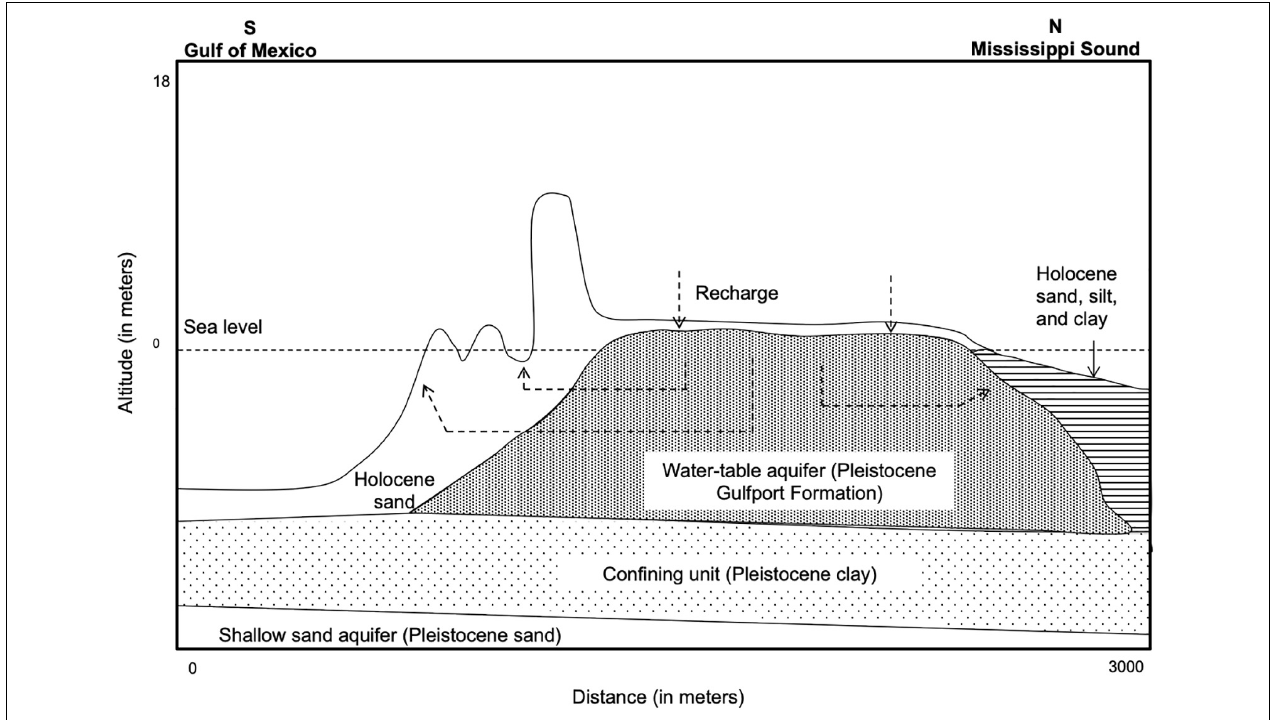
FIGURE 6 | Conceptual sketch of groundwater flow across Dauphin island from the center of the Island to the Gulf of Mexico in the south and Mississippi Sound in the north. The generalized south-north hydrogeological section of Dauphin Island is modified from Otvos